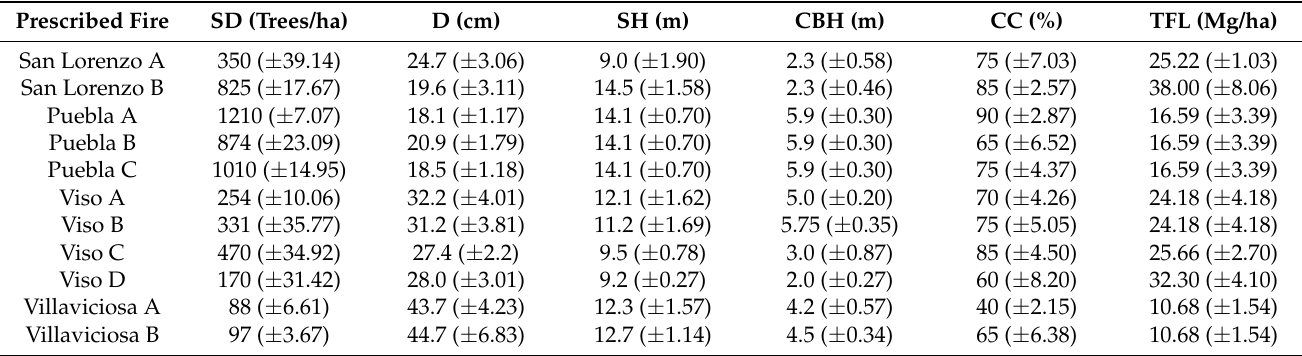
Table 2. Characterization of stand structure for each